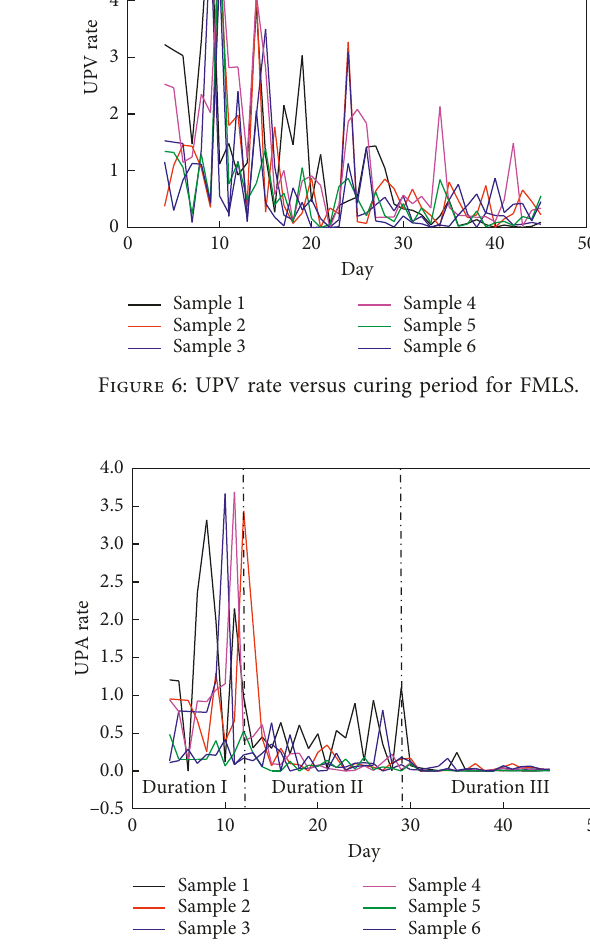
Figure 7: UPA rate versus curing period for FMLS.